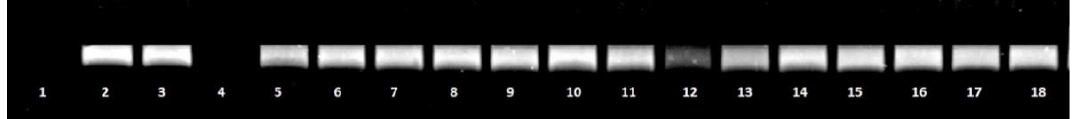
Figure 2. Effect of the tested compounds on S. aureus topoisomerase IV activity. Decreasing amounts of compounds 14 and 6 were incubated with 200 ng kinetoplast DNA and run on agarose gel. Lane 1: incubation mixture without enzyme (negative control). Lane 2: S. aureus topoisomerase IV assay with dilution buffer (control). Lane 3: S. aureus topoisomerase IV with DMSO (control). Lane: 4: Ciprofloxacin at concentration 32 μg/mL. Lane: 5–11: compound 14 at concentrations 64, 32, 16, 8, 4, 2, 0.5 μg/mL, respectively. Lane: 12–18: compound 6 at concentrations 64, 32, 16, 8, 4, 2, 0.5 μg/mL, respectively.